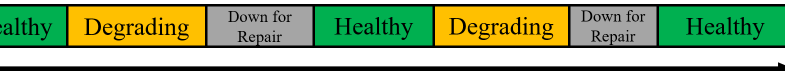
Figure 4. Example operating